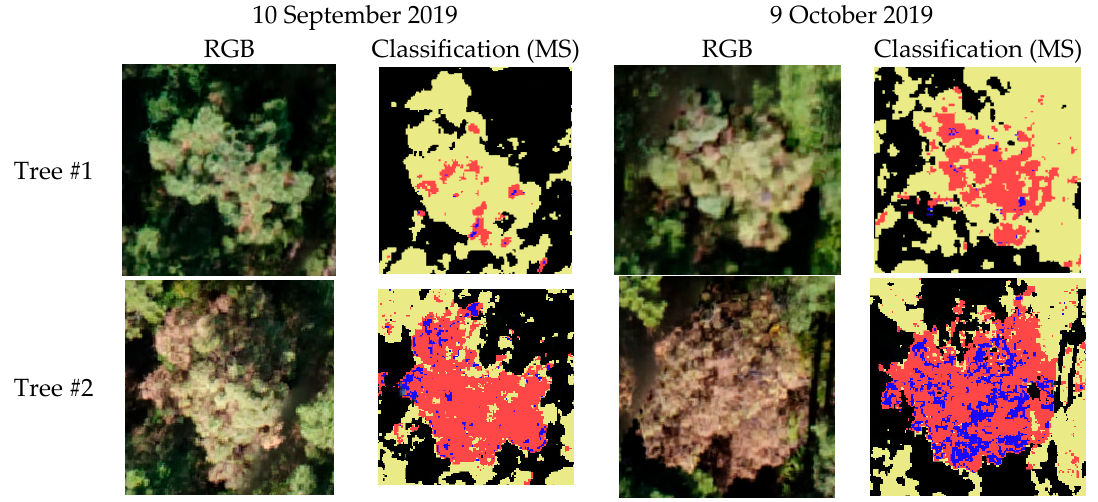
Figure 14. Temporal evolution of the disease, reflected by the classification maps. Color code of classified pixels: blue = infected, red = suspicious, yellow = healthy. classified pixels: blue = infected, red = suspicious, yellow =